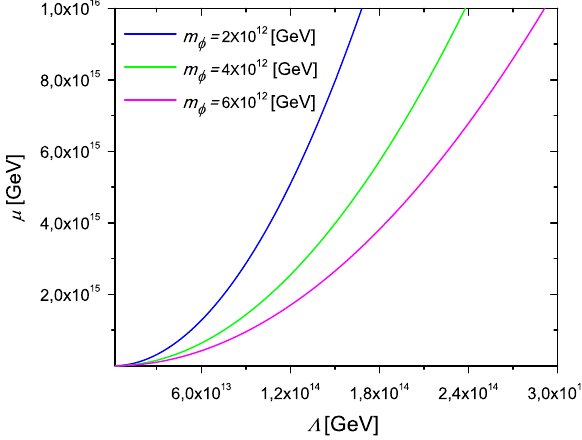
Fig. 4 Mass scale μ versus mass scale Λ (both in GeV) for three different values of the inflaton mass, 2 × 10 12 GeV (blue), 4 × 10 12 GeV (green) and 6 × 10 12 GeV